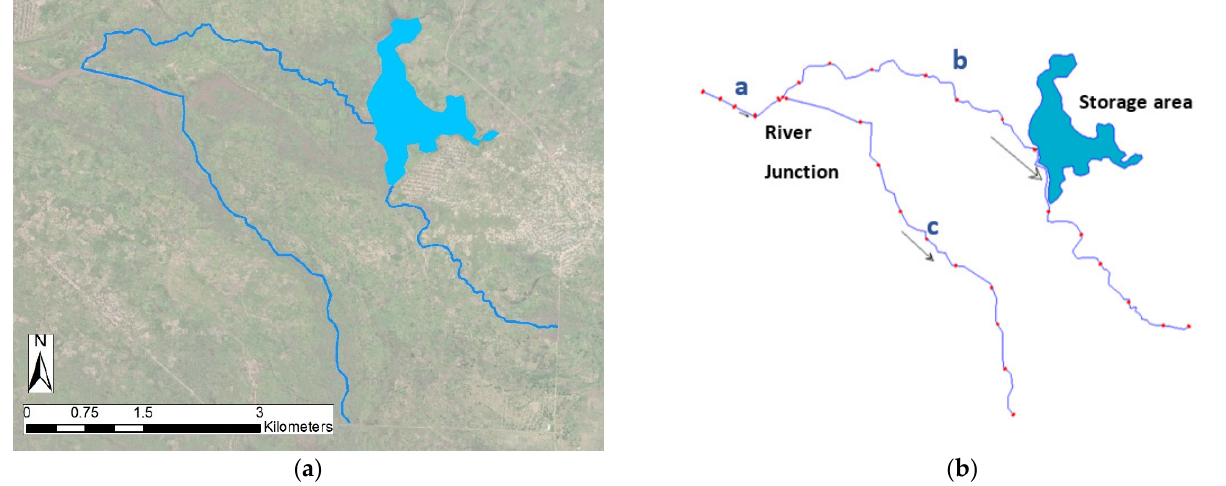
Figure 11. ( a ) Map of the intervention proposed: considered channels and natural reservoir. ( b ) HEC-RAS scheme used for the modelling: reaches, river junction, storage area and sections.